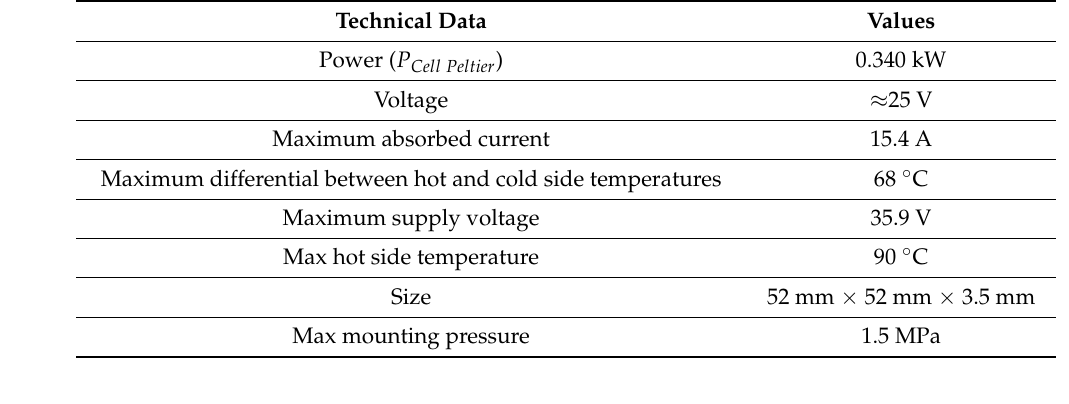
Table 3. Peltier cell technical details.